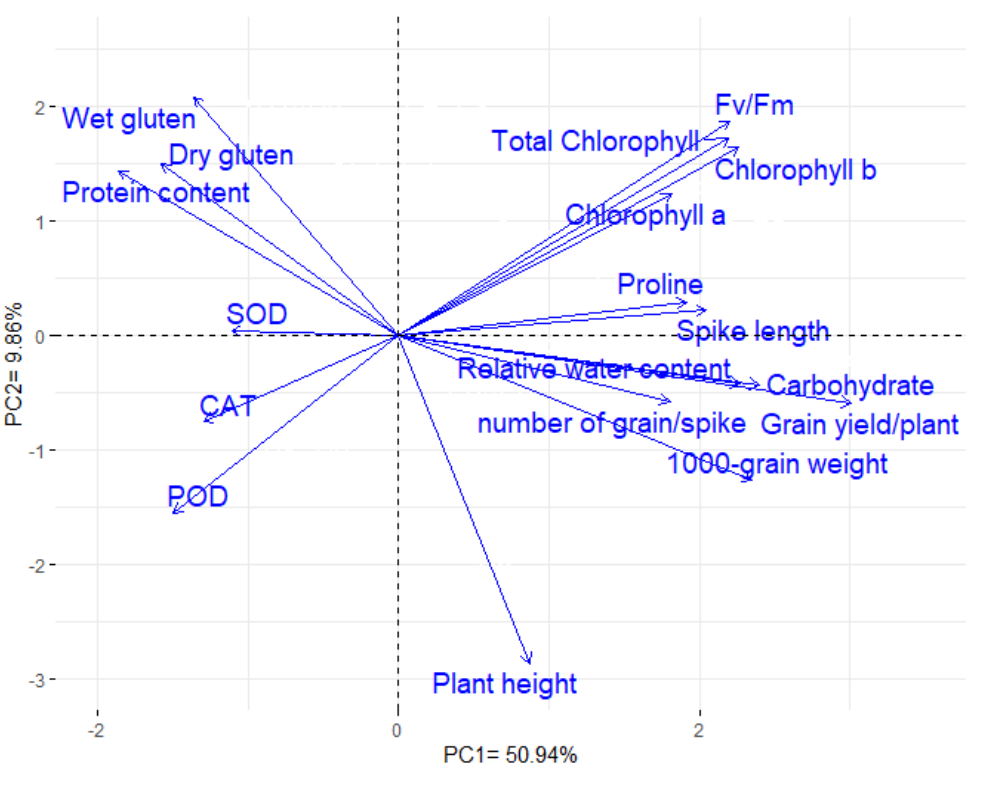
Figure 6. PC-biplot presents the relationship among the evaluated physiological, agronomic, and quality traits.